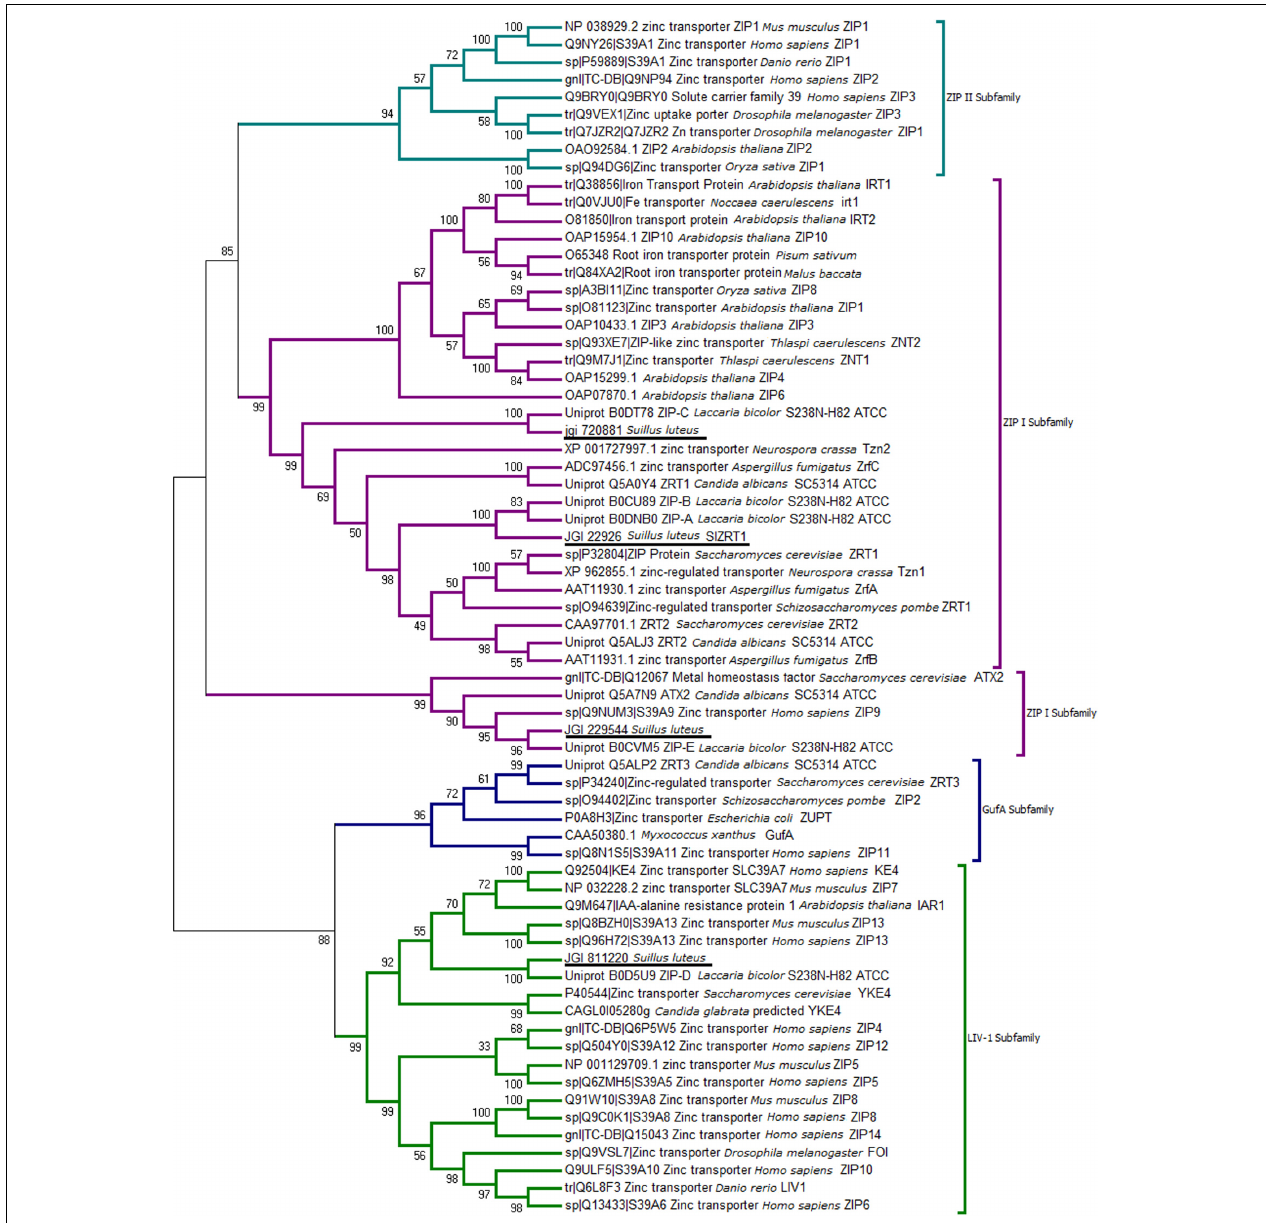
FIGURE 1 | Neighbor-joining (NJ) tree of the Zrt- Irt- like protein (ZIP) family with sequences from selected fungi and characterized ZIP proteins from other species. Sequences were aligned by the Multiple Alignment using Fast Fourier Transform (MAFFT version 7) algorithm, bootstrap values (1000 replicates) are indicated, and Suillus luteus sequences are